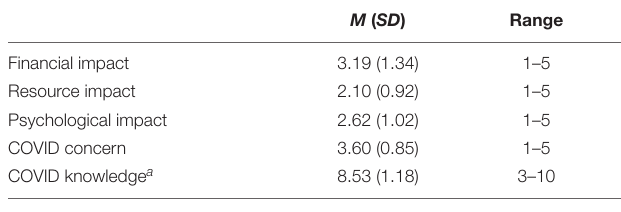
TABLE 2 | COVID-related sample